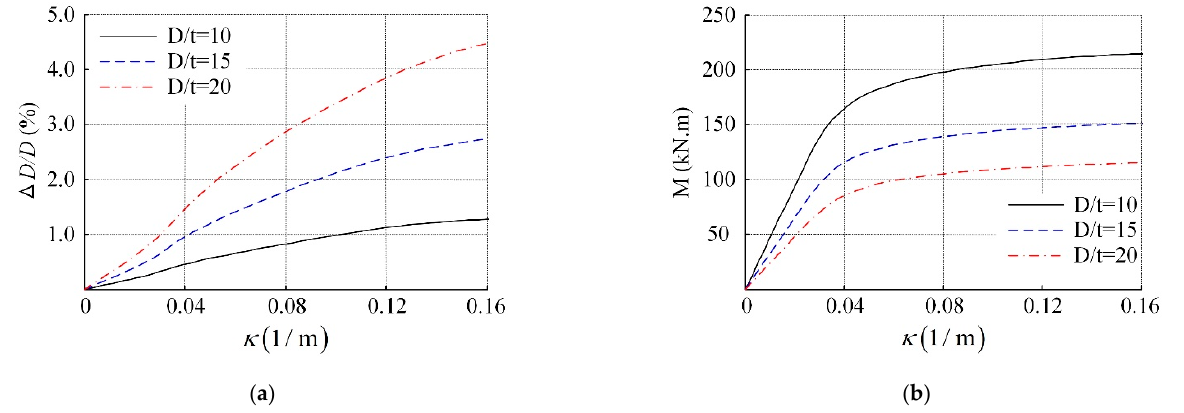
Figure 15. Effect of D/t on ovalization and bending moment during pipe reeling: ( a ) variation of ovalization with curvature, ( b ) variation of bending moment with curvature.